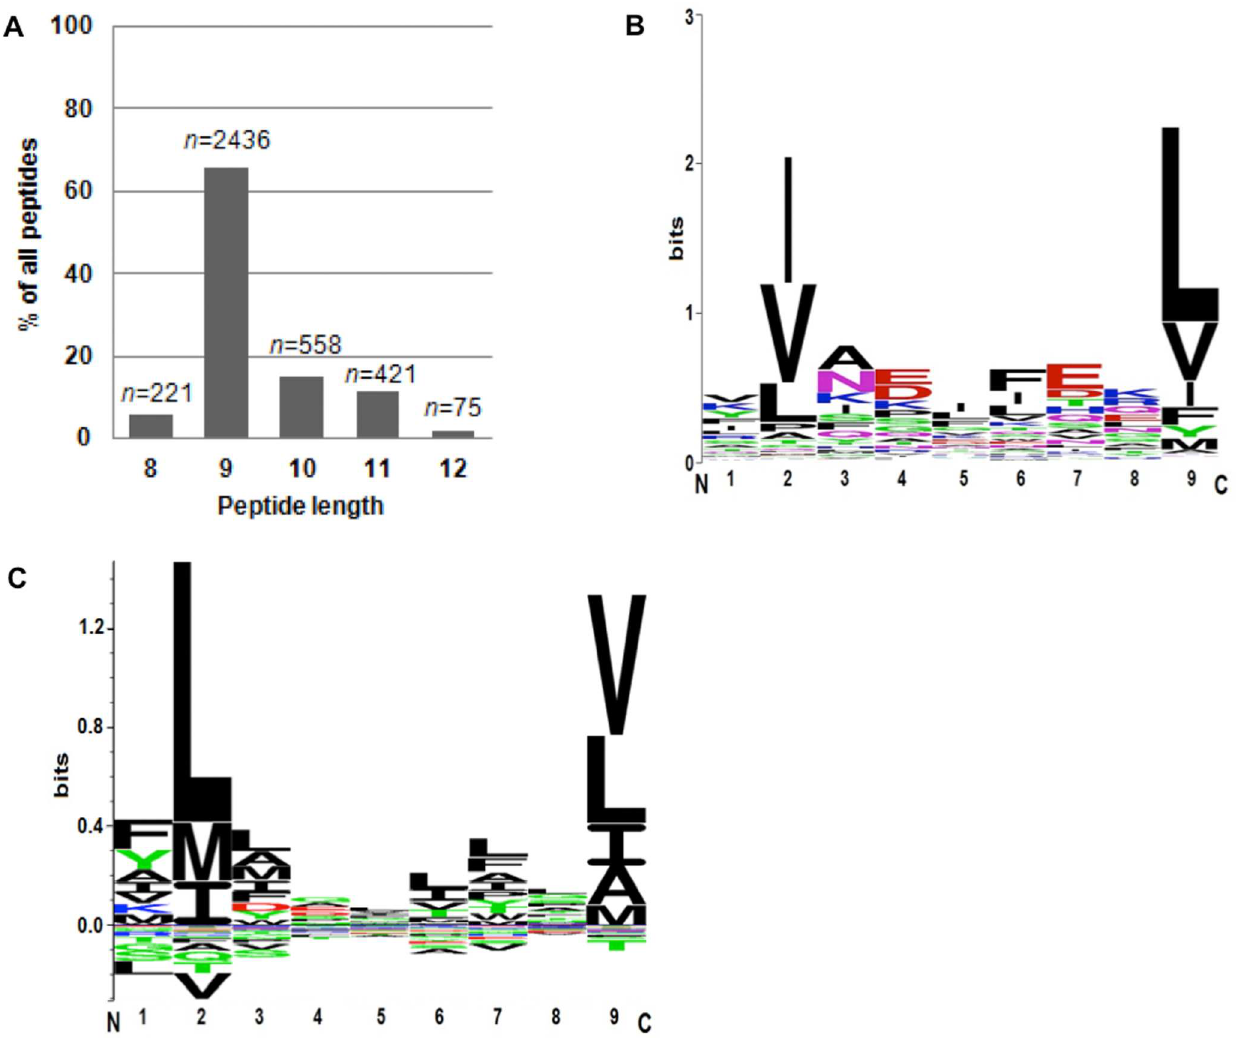
Fig 2. The MHC binding motif of peptides deriving from C1R-DLA-88 * 50101and K562-DLA-88 * 50101cells. (A) The averagelength distributionof MHC peptideligandsderivingfrom C1R and K562 cells transfected with DLA-88 * 50101shows that the majority of peptides are 9 residues in length( n = 2436; 65.5%). (B) Summary bindingmotif of DLA-88 * 50101. Nonamersderivingfrom C1R-DLA-88 * 50101cells, (Exp. 1– 3) as well as peptides elutedfrom K562-DLA-88 * 50101 cells (Exp. 4), were characterized and revealeddominant anchorresidues at position2 and 9. (C) Bindingmotif of HLA-A * 02:01. Derivationof data is describedin the “Materialsand Methods”